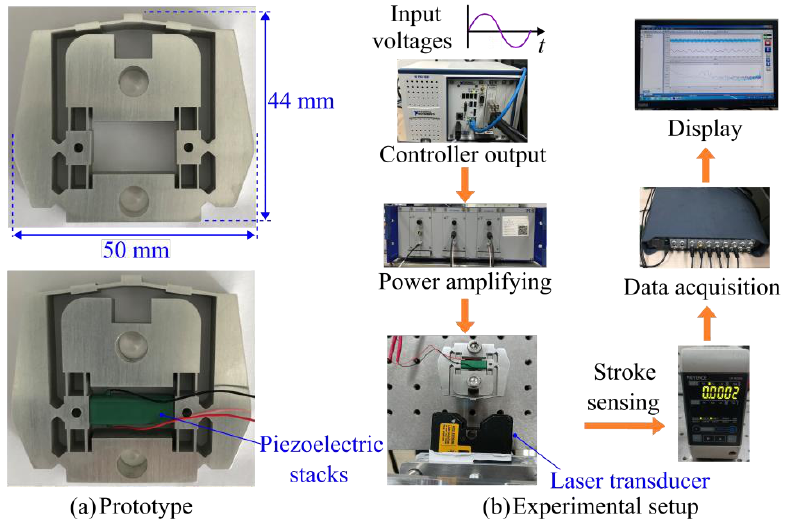
Figure 13. Prototype and the experimental setup for measuring the static and dynamic perfor- mances. ( a ) Prototype. ( b ) Experimental